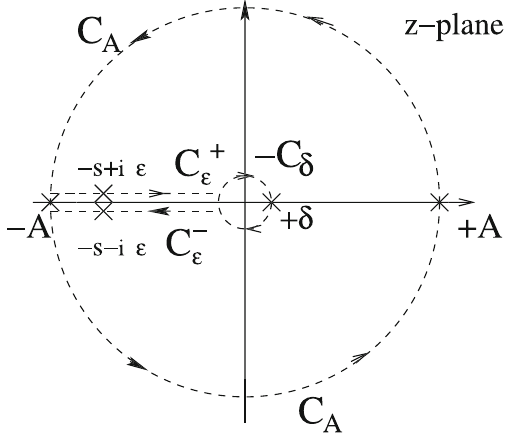
Fig. 6 The closed integration path in the complex z -plane for the inte- gral Eq. (A3): C A is the (counterclockwise) circular path of radius A ( A > 0); C ± ε are the linear paths parallel to the negative axis ( z = − s ± i ε , − A ≤ s ≤ − δ ; − C δ is the (clockwise) circular path of radius δ . The limit ε (cid:15) δ → + 0 is taken, i.e., first ε → + 0 and then δ → +